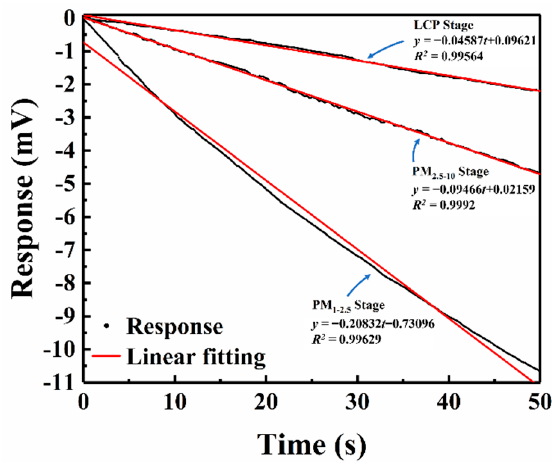
Figure 15. The response of collecting particulate aerosol and its linear fitting result.